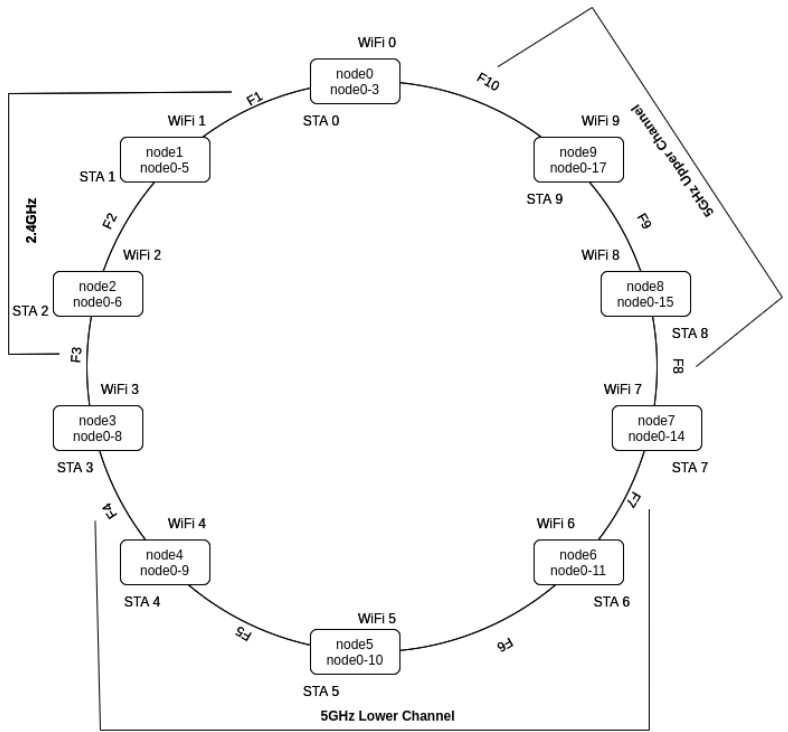
Figure 8. W-iLab1.t ring topology node